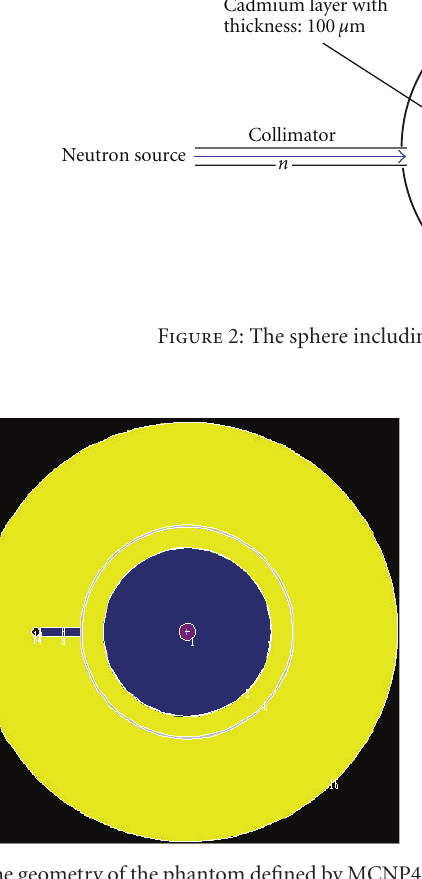
Figure 3: The geometry of the phantom defined by MCNP4C code.